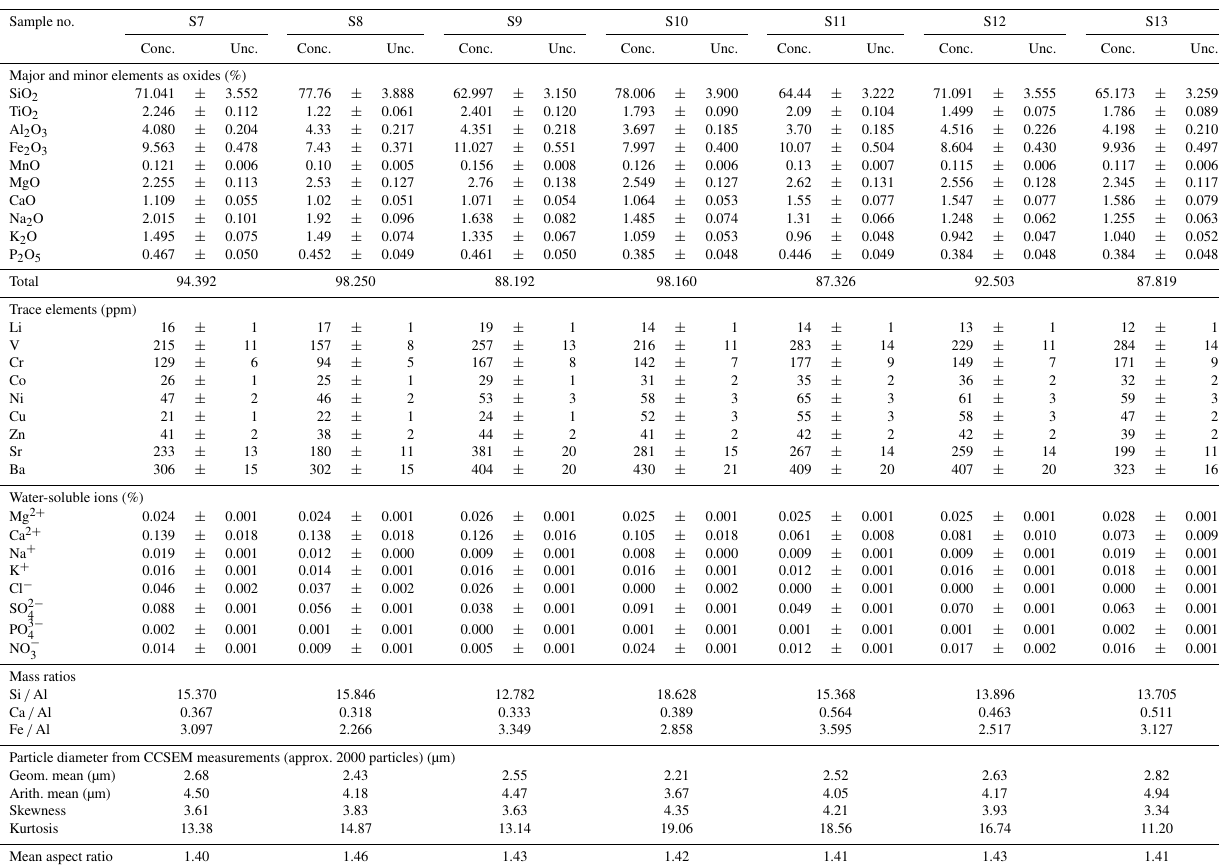
Table A2. Major, minor and trace element concentrations (Conc.) and analytical uncertainties (Unc.) of grab samples S7 to S9 collected near Yanbu and S10 to S13 near Mecca, all along the Red Sea coastal region. Also tabulated are elemental mass ratios, statistics of the individual particle size and morphology as measured by CCSEM. Sampleno.